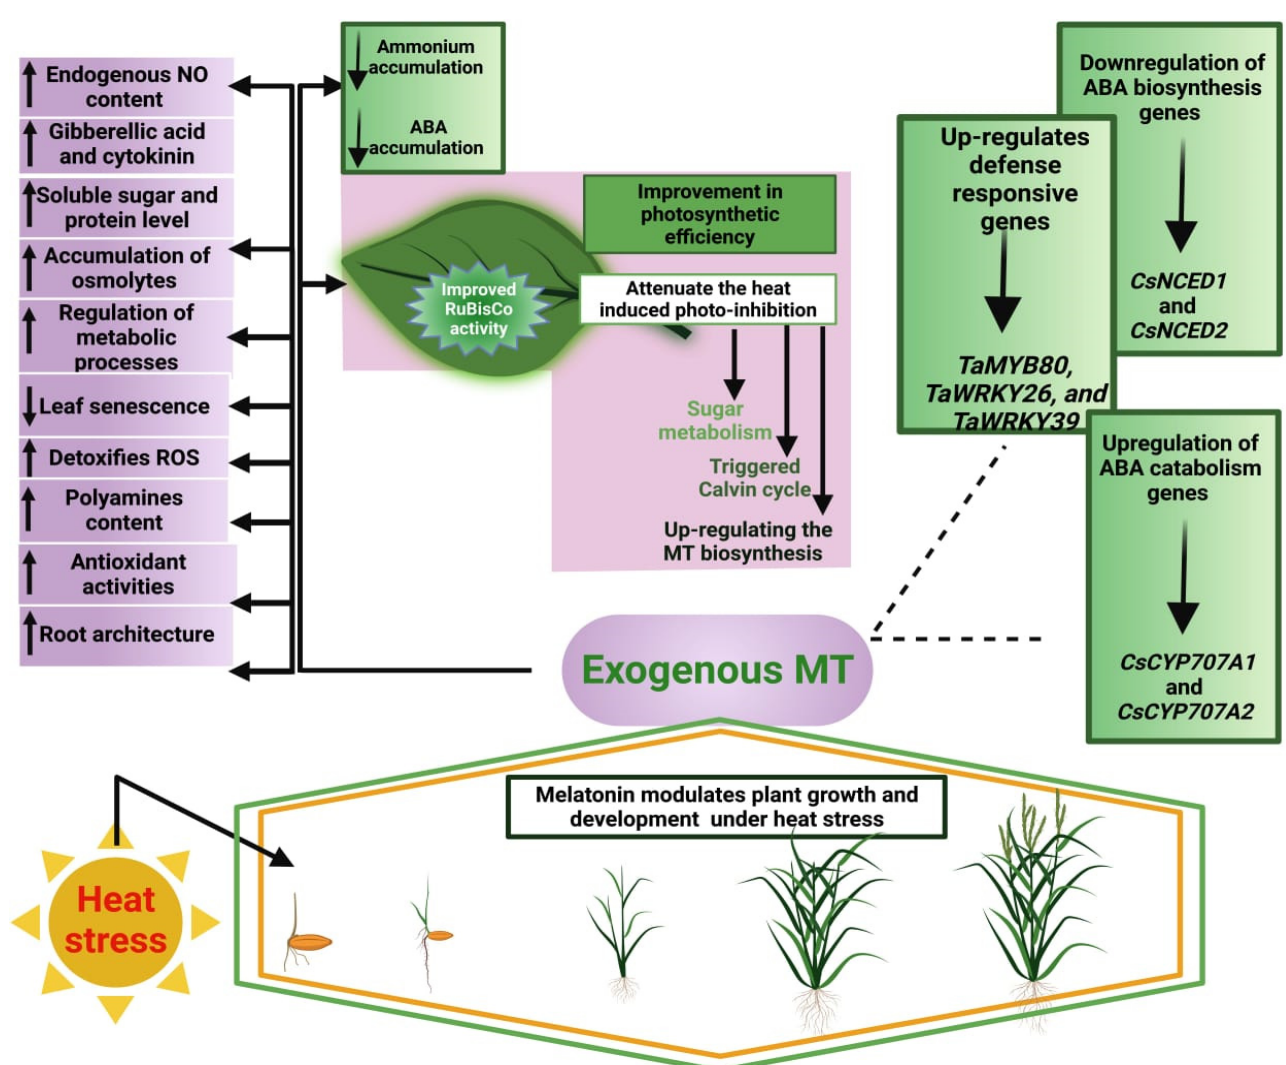
Figure 2. MT application protects the photosynthetic apparatus, and improves gene expression, osmolytes accumulation, maintains metabolic processes, improves polyamines and hormones accu- mulation, and decreases leaf senescence and ROS, resulting in a marked improvement in growth under HS.